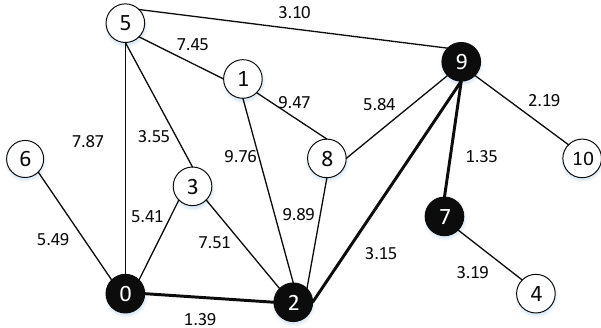
Figure 2. An example of dominating tree on the